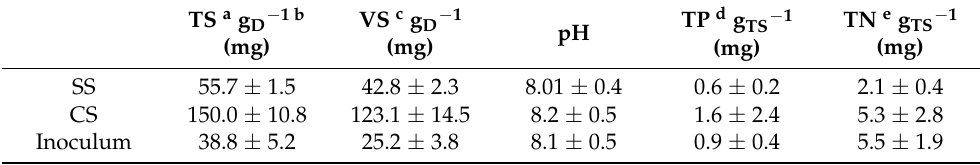
Table 1. The characteristics of substrates used in the anaerobic digestion (AD)